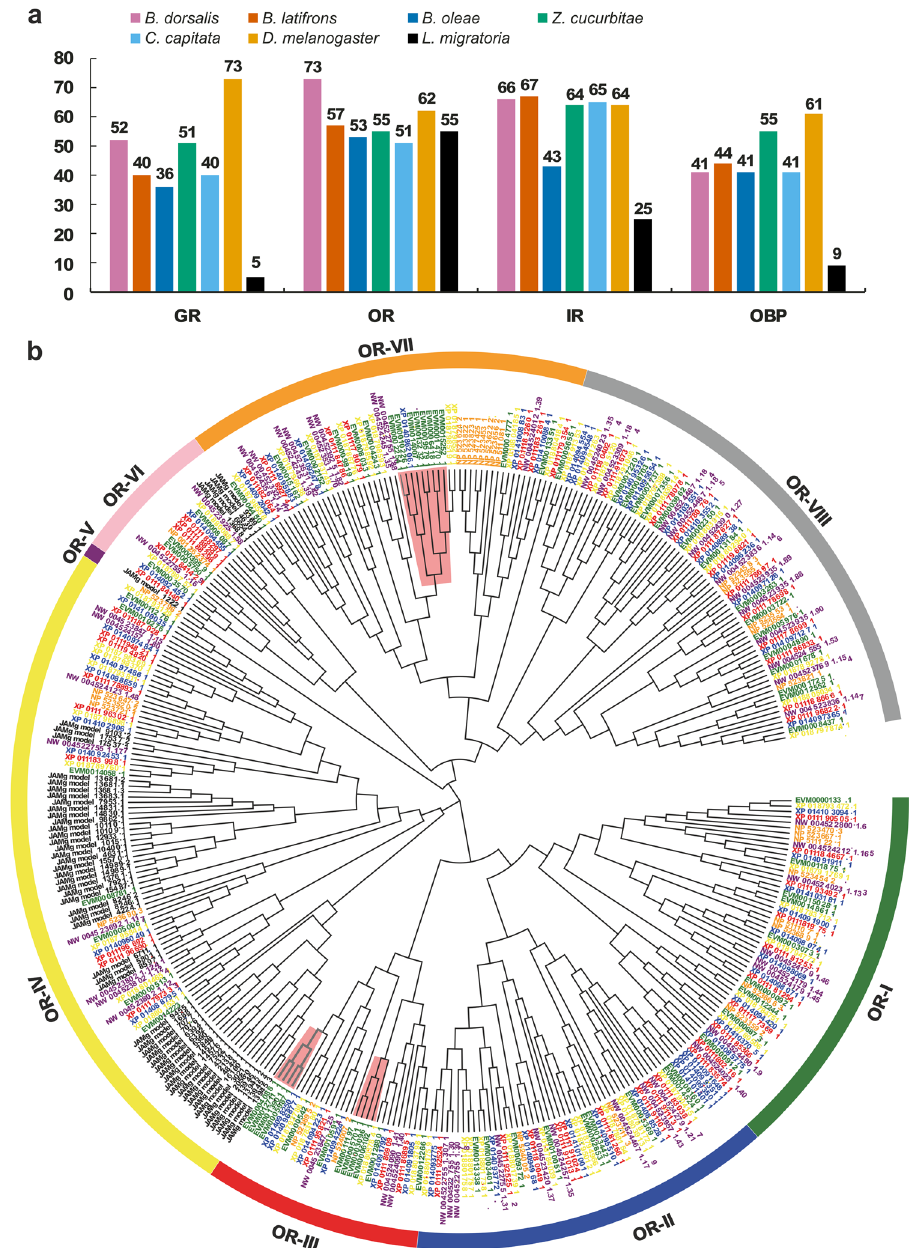
Fig. 5 Gene families involved in chemoreception in Bactrocera dorsalis . a Comparison of gene numbers for GR, OR, IR and OBP proteins in B. dorsalis , B. latifrons , B. oleae , Z. cucurbitae , C. capitata , D. melanogaster , and L. migratoria . Gene numbers are provided above each bar. b Phylogenetic relationships of OR proteins from B. dorsalis , B. latifrons , B. oleae , Z. cucurbitae , C. capitata , D. melanogaster , and L. migratoria . IQ-TREE was used to build the unrooted maximum- likelihood phylogenetic tree with the LG + G4 model for 1000 bootstrap replicates. OBPs odorant-binding proteins; GRs gustatory receptors; ORs olfactory receptors; IRs ionotropic